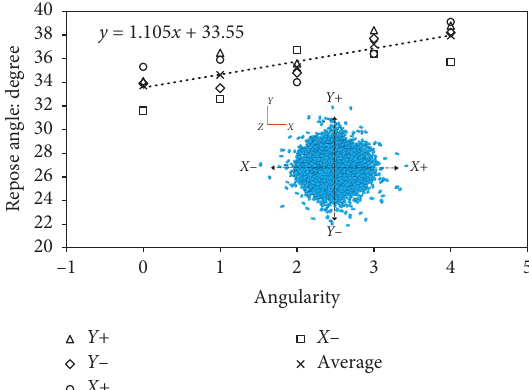
y = 1.105 x + 33.55